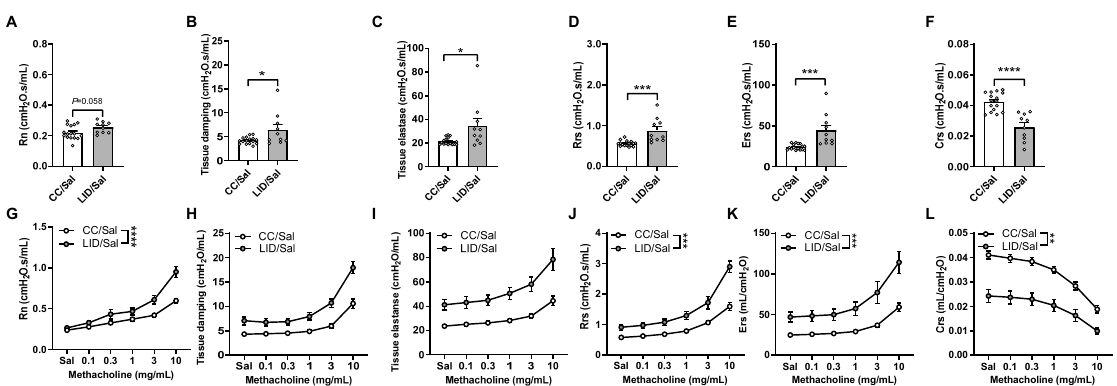
Figure 2. Low iron diet (LID) during pregnancy increases airway hyperresponsiveness (AHR), indicative of impaired lung function, in male and female offspring. Baseline lung function was assessed in terms of ( A ) central airway resistance (Rn), ( B ) tissue damping, ( C ) tissue elastance, ( D ) transpulmonary resistance (Rrs), ( E ) elastance (Ers), and ( F ) compliance (Crs). The response to methacholine provocation was assessed in terms of ( G ) Rn, ( H ) tissue damping, ( I ) tissue elastance, ( J ) Rrs, ( K ) Ers, ( L ) Crs. ( A – F ) Analysed by unpaired student t -test, ( G – L ) analysed by 2-way ANOVA and statistics at maximal dose from AHR curves presented. n = 10–16 mice per group. Data are presented as mean ± SEM (* p < 0.05; ** p < 0.01; *** p < 0.001; **** p < 0.0001).